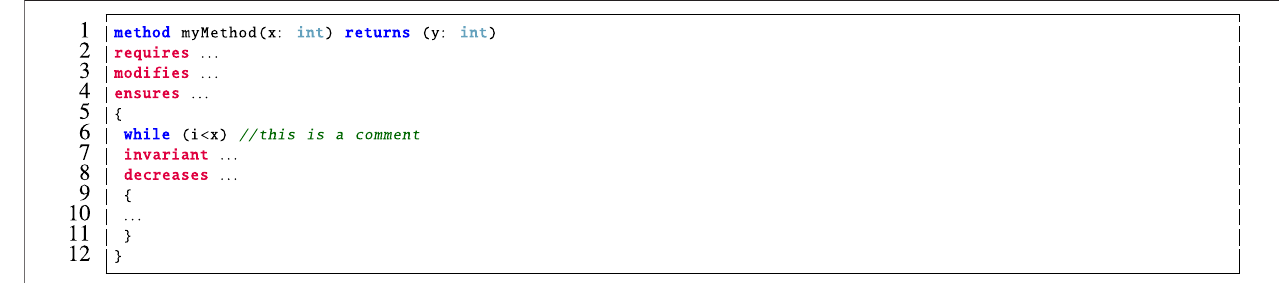
FIGURE 3 | The basic structure of a method with speci fi cation constructs in Dafny.